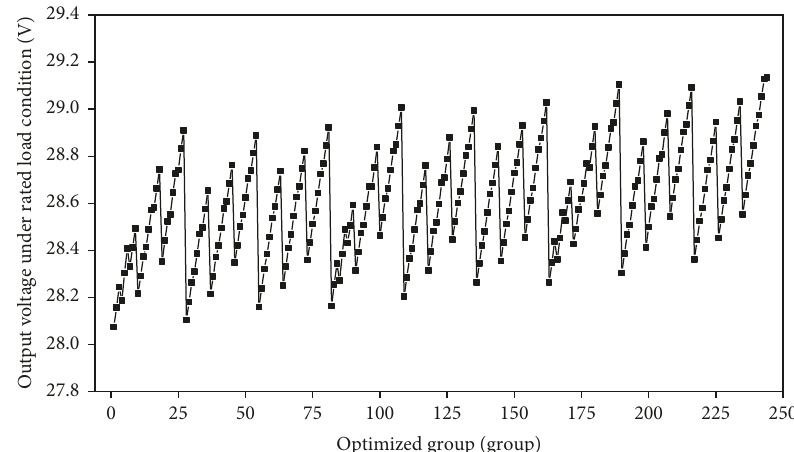
Figure 20: Variation curve of generator output voltage under rated load condition with different optimal